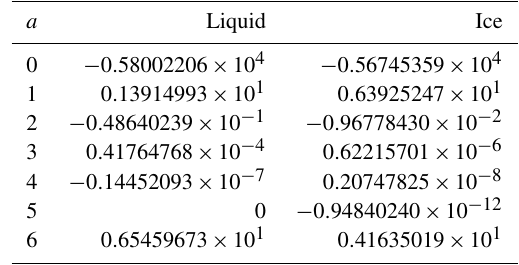
Table 4. Coefficients for saturated water vapour in Eq.